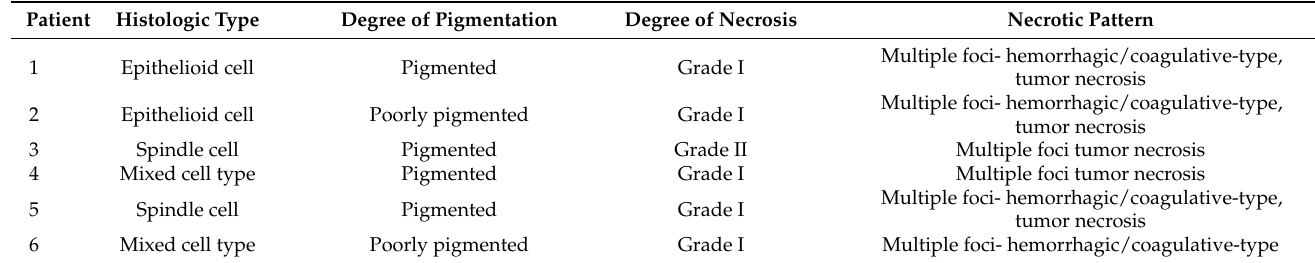
Table 5. Histopathological features of uveal melanomas in the nonirradiated